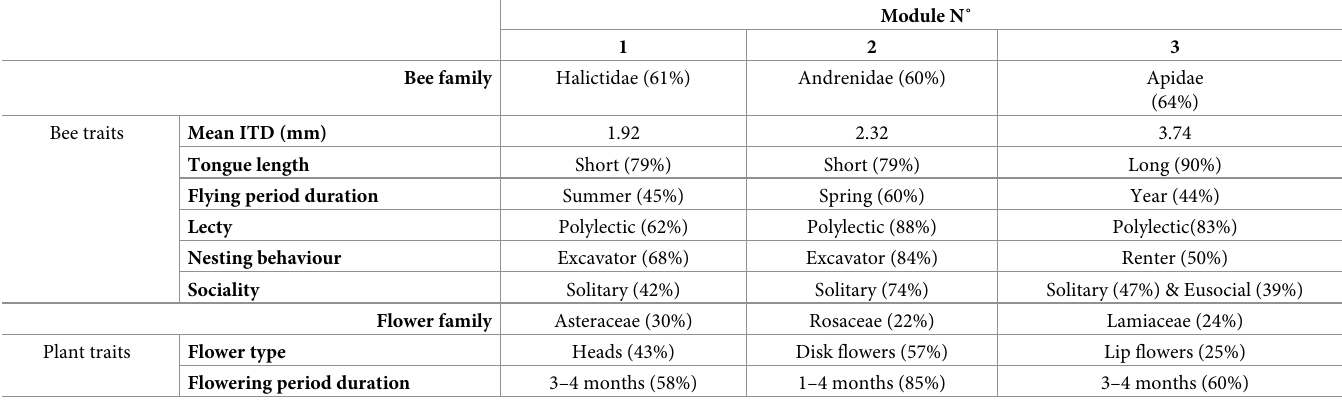
Table 2. Characteristics of the three main modules (containing � 10 bee species) in terms of the traits of bees and plants with which they interact.